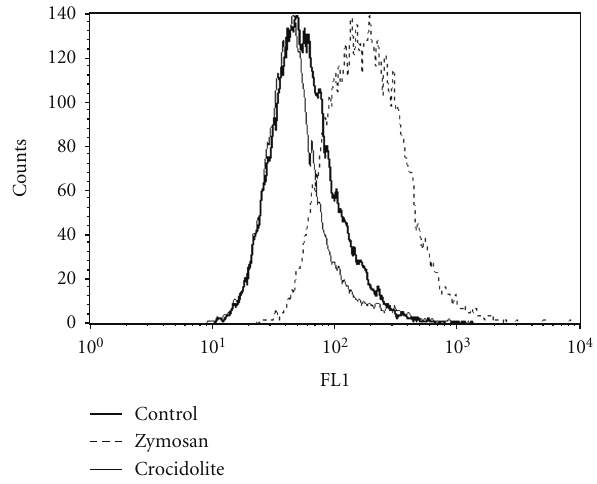
Figure 2: ROS production in NR8383 analysed by flow cytometry. NR8383 cells were preincubated with H 2 DCFDA (25 μ m) for 30 minutes and then exposed to 10 μ g/cm 2 of crocidolite or zymosan for 3 hours. Representative histograms plot the relative green DCF fluorescence (FL1) within 15000 live cells (counts: numbers of